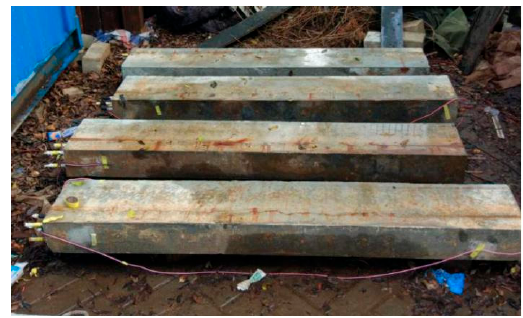
Figure 6. Test specimens subjected to the dry–wet cycles corrosion.